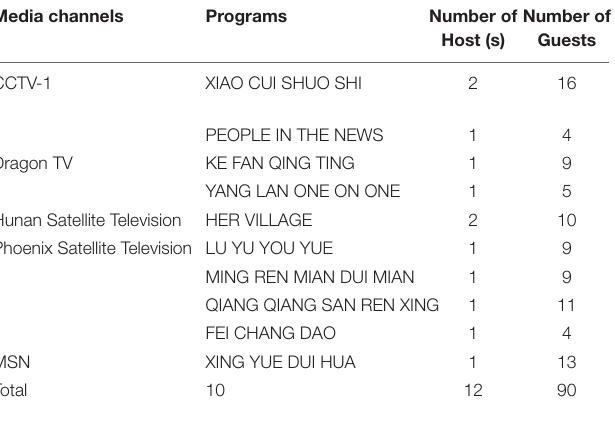
TABLE 1 | Profile of the interview